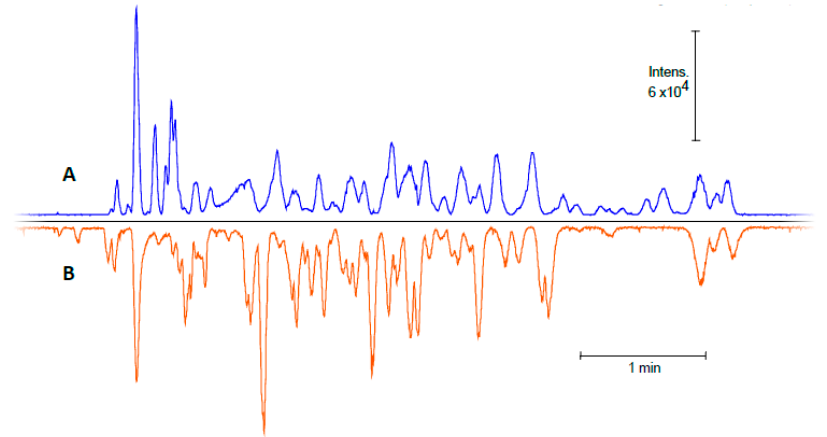
Figure 5. Comparison of the obtained CZE-MS electropherograms after in-solution ( A ) and in-line digestion ( B ) of the human serum albumin sample. Conditions for in-line digestion are as described at Figure 4; for the measurement of in-solution digest, the formation of the trypsin layer was omitted.